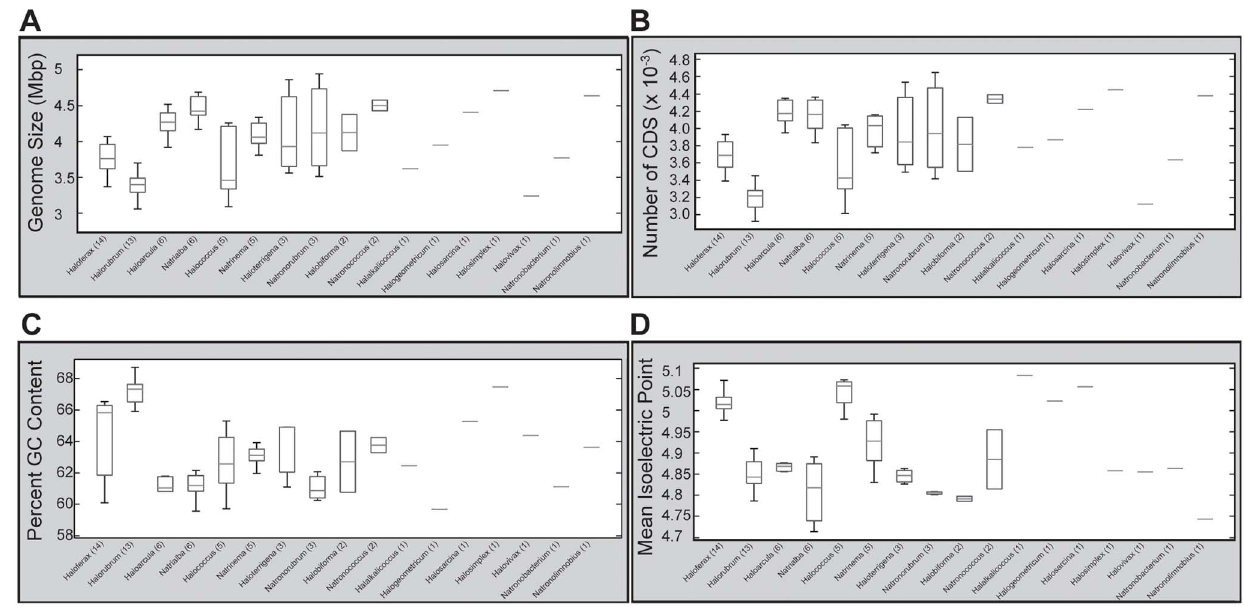
Figure 8. Genera-level comparisons of genomic features. Assembled genome size (Mbp) (A), number of predicted protein coding sequences (B), %G + C (C), and mean protein isoelectric point (D) were extracted from each genome, organized by genus, and boxplots calculated using MATLAB’s Statistics toolbox. Boxplots were generated using 25 th and 75 th percentile as box edges, with median demarcated with horizontal line within box. Genera are ordered by descending number of species sequenced, with the number of species shown in parentheses. Genera with only a single sequenced member are shown as horizontal lines.